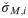
Relationship between sample innovation standard deviations σˇM,i(normalized in the AMOC experiment) and sample lag-1 autocorrelations of model anomalies during the calibration ρˇM,i for each model, and projected changes (projected mean minus reference period mean) for the experiments using simulated data.